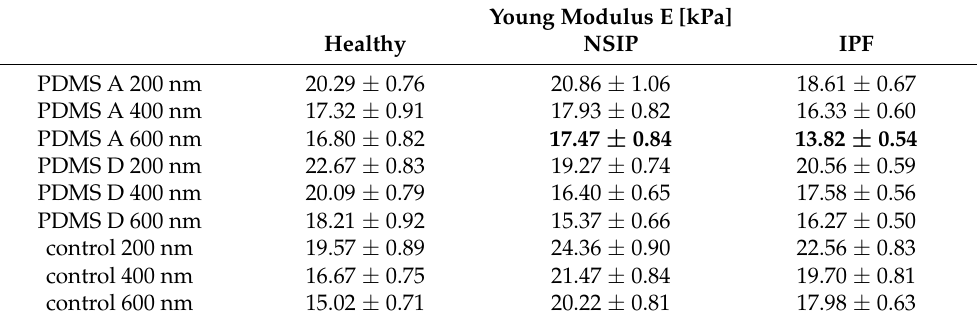
Table 1. Stiffness of healthy, NSIP- and IPF-derived fibroblasts (mean ± SE) determined for different substrates (PDMS A, PDMS D, glass) and for different indentation depths (200, 400, 600 nm).